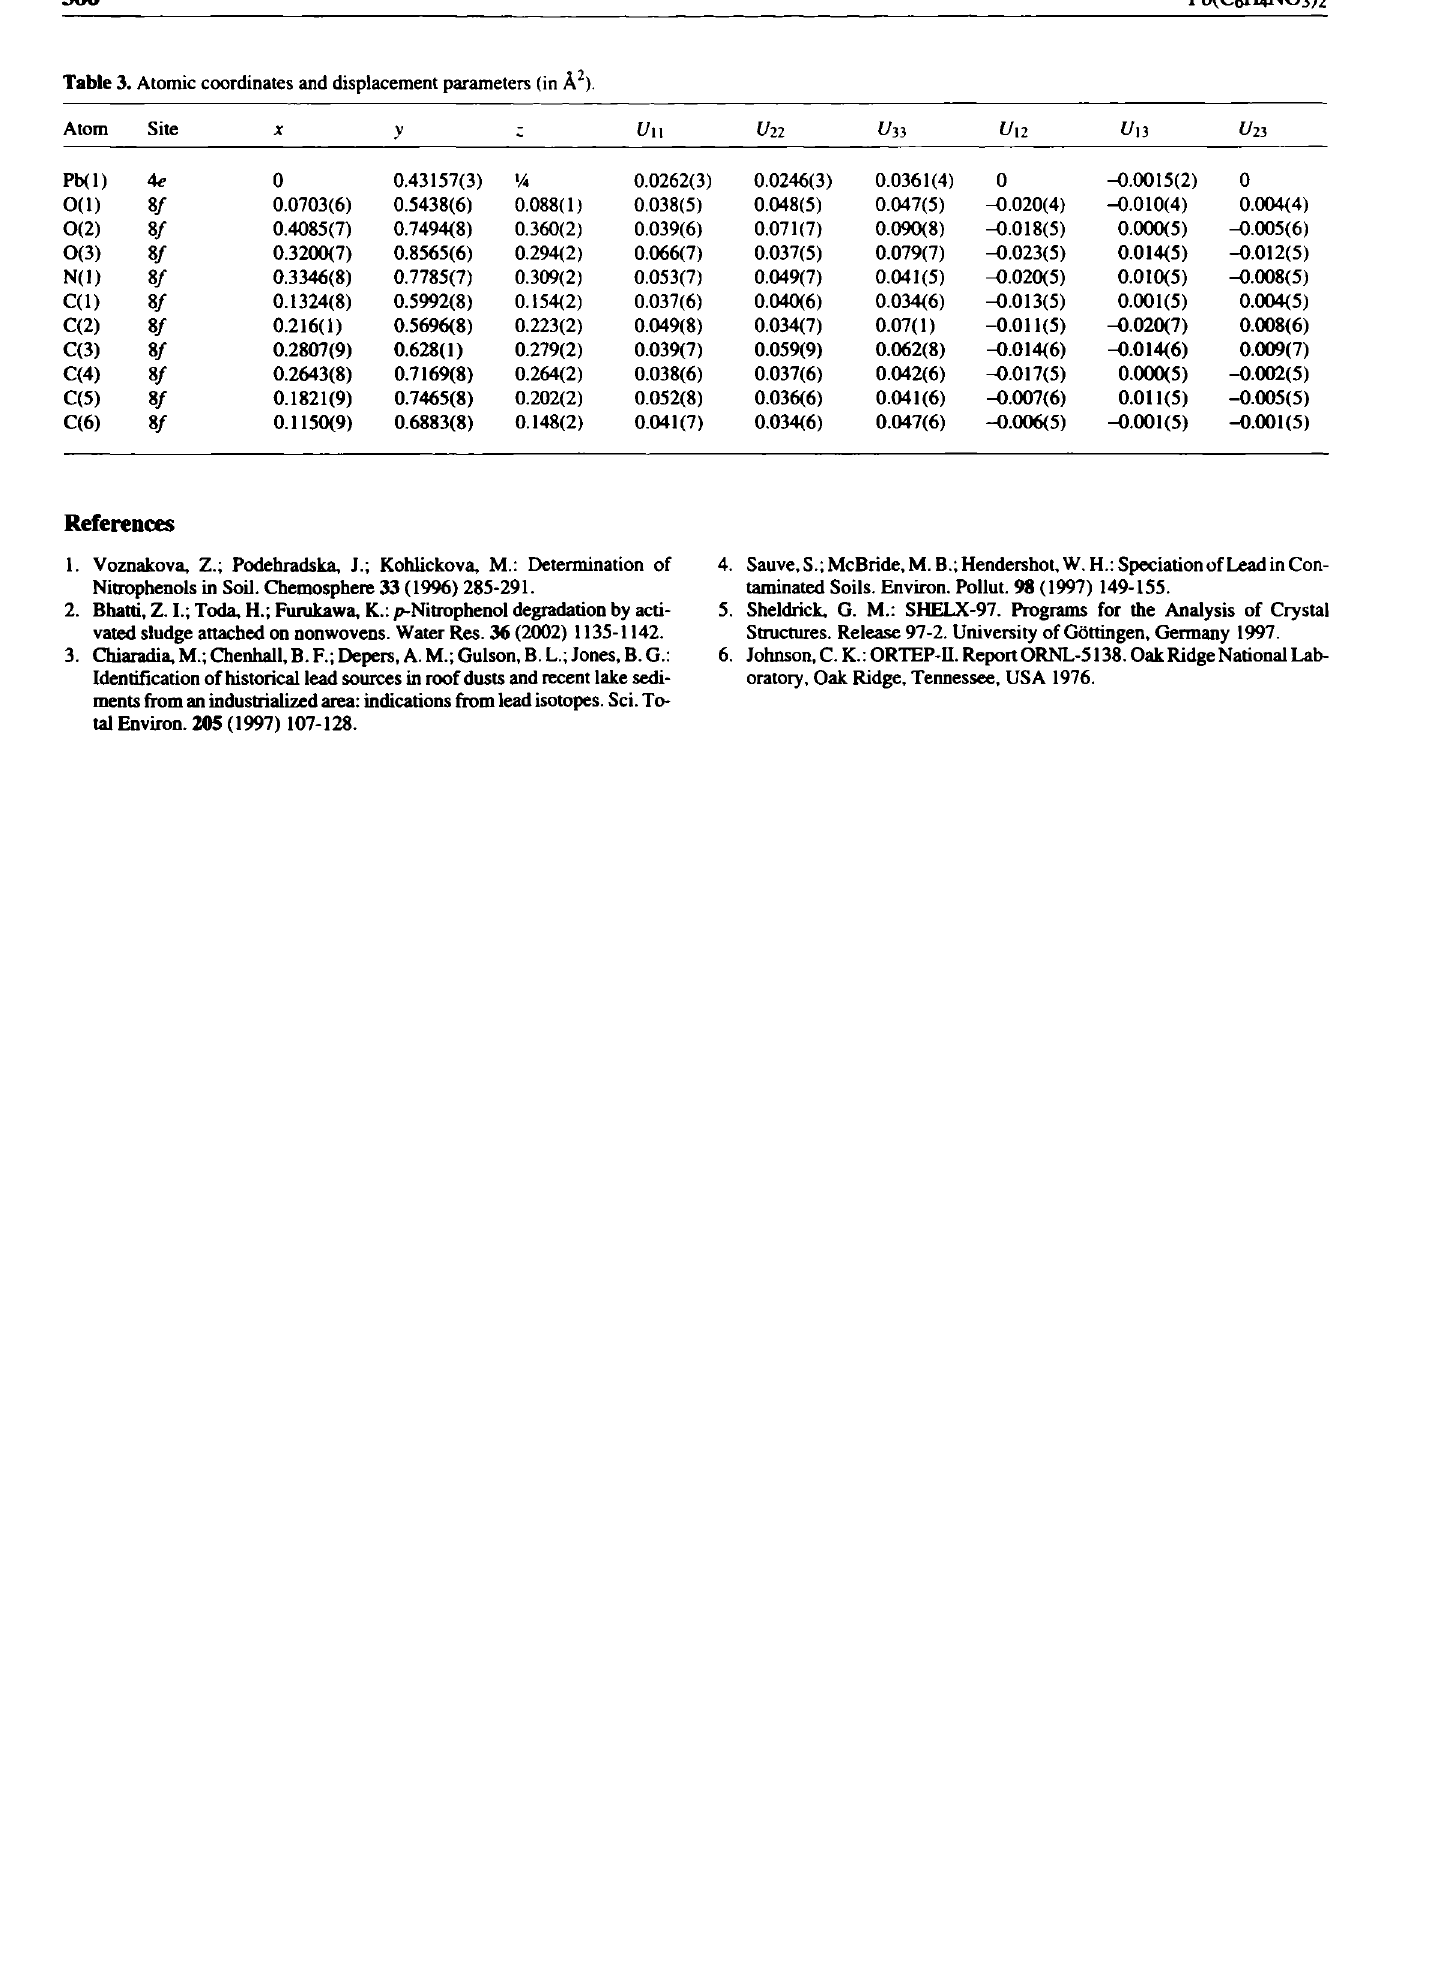
Table 3. Atomic coordinates and displacement parameters (in A 2